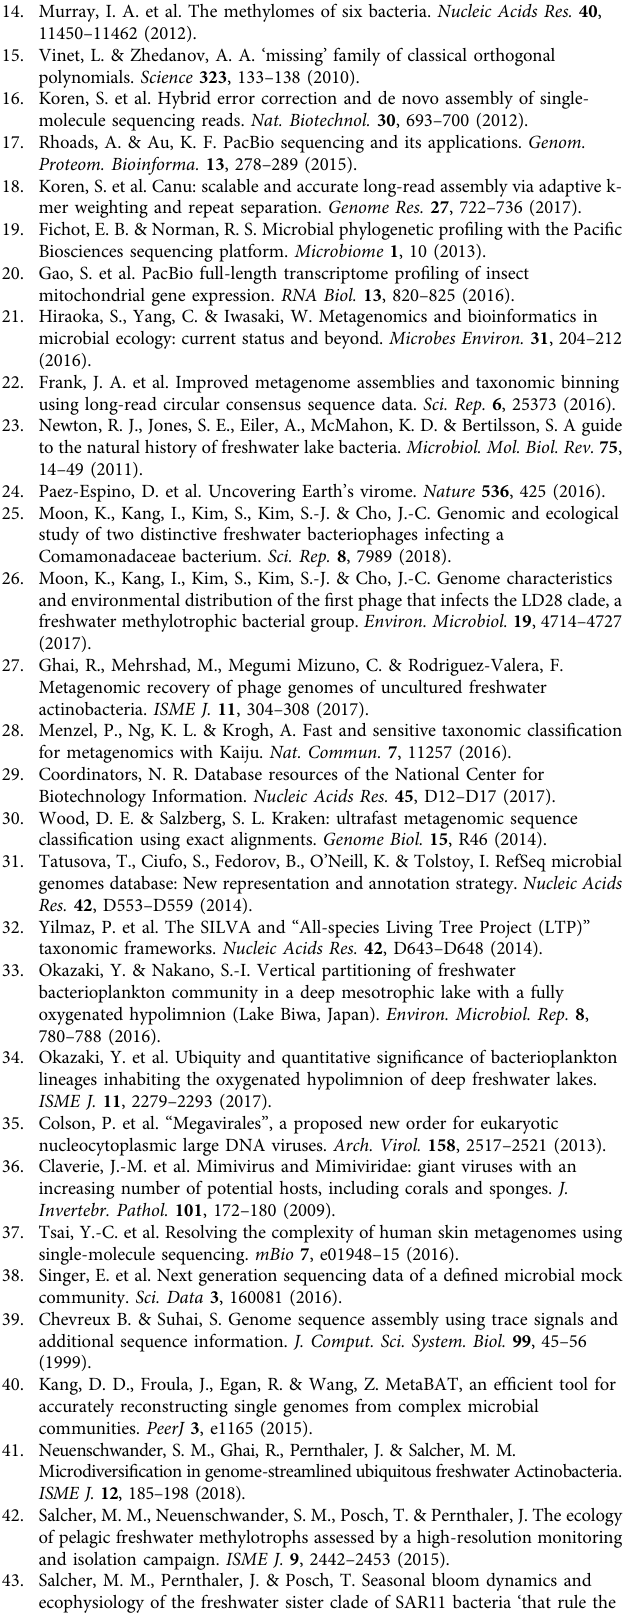
Supplementary Table 1. For veri fi cation of the EMGBS10_10070 gene function, the 5 ′ -ACGAGTC-3 ′ sequence was inserted downstream of the termination codon for the sake of the methylation assay (the fi rst fi ve-base ACG A G sequence was the estimated methylated motif, and the last fi ve-base GAGTC is recognized by the restriction enzyme PleI) (Supplementary Data 1). The constructs were transformed into E. coli HST04 dam − / dcm − (Takara Bio), which lacks dam and dcm MTase genes. The E. coli strains were cultured in LB broth medium supplemented with ampicillin. MTase expression was induced according to the supplier ’ s protocol. Plasmid DNAs were isolated using the FastGene Xpress Plasmid PLUS Kit (Nippon Genetics). SalI was employed to linearize the plasmid DNAs encoding EMGBS3_12600 and EMGBS15_03820 and then inactivated by heat. Methylation statuses were assayed by enzymatic digestion using the following restriction enzymes: BceAI and TseI for EMGBS3_12600, DpnII and XmnI for EMGBS15_03820, Ple I for EMGBS10_10070, and Fok I for EMGBD2_08790. All restriction enzymes were purchased from New England BioLabs. All digestion reactions were performed at 37 °C for 1h, except for those involving TseI (8h) and FokI (20 min). Notably, although TseI digestion is conducted at 65°C in the manufacturer ’ s protocol, we adopted a temperature of 37°C to avoid cleavage of methylated DNA. We further veri fi ed the methylated motifs that were newly estimated in this study, i.e., those of EMGBS10_10070 and EMGBD2_08790. Chromosomal DNA was extracted from cultures of the transformed E. coli strains using a PowerSoil DNA Isolation Kit (QIAGEN) according to the supplier ’ s protocol. SMRT sequencing was conducted using PacBio RSII (Paci fi c Biosciences), and methylated motifs were detected via the same method described above.